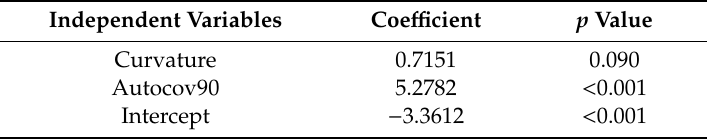
Table 7. Variables contained in the ALR model and their coe ffi cients.